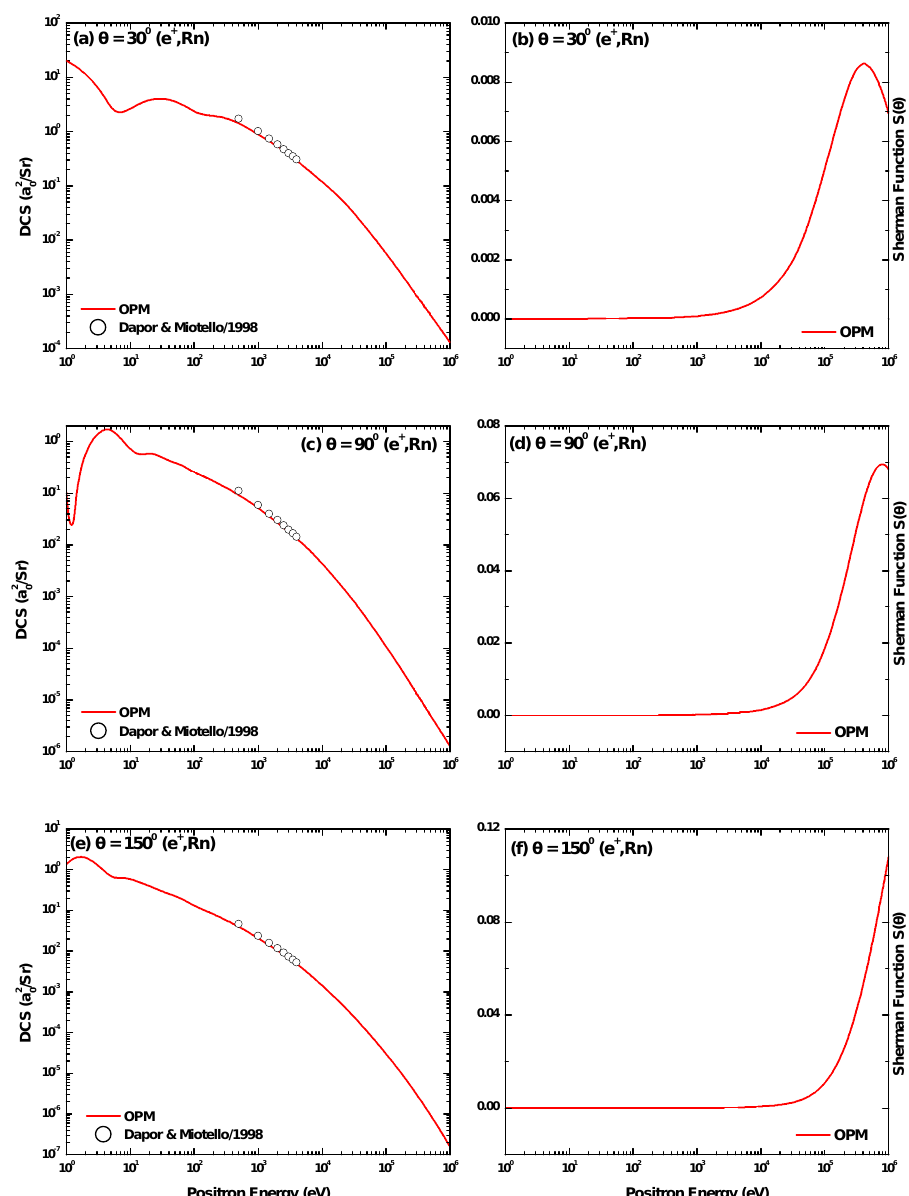
Figure 23. Energy dependence of the DCS and the Sherman function for positrons elastically scattered from neutral radon atoms at scattering angles ( a , b ): 30 ◦ , ( c , d ): 90 ◦ and ( e , f ): 150 ◦ . Energy dependence of the spin polarization parameters U and T for positrons elas- tically scattered from neutral radon atoms are depicted in Figure 24 at θ = 30 ◦ , 90 ◦ and 150 ◦ . It is observed in this figure that, as expected, the variation of U and T with energy are opposite to each other. Starting from zero, the magnitude of | U ( θ ) | increases very slowly up to E i = 10 keV, and beyond that it increases rapidly and reaches its maximum value. The maximum value of | U ( θ ) | is obtained at θ = 90 ◦ . Below and beyond this scattering angle, the | U ( θ ) | values decrease. The parameter T , on the other hand, starts at its maximum and slowly decreases with energies. Beyond E i = 10 keV, the values of | T ( θ ) | sharply fall to its minimum, which is the lowest at θ = 90 ◦ . We are not aware of any experimental or any other theoretical studies regarding these parameter for e ± − Rn scattering. We expect that the present study will encourage both experimental and theoretical groups to pay their attention to this scattering